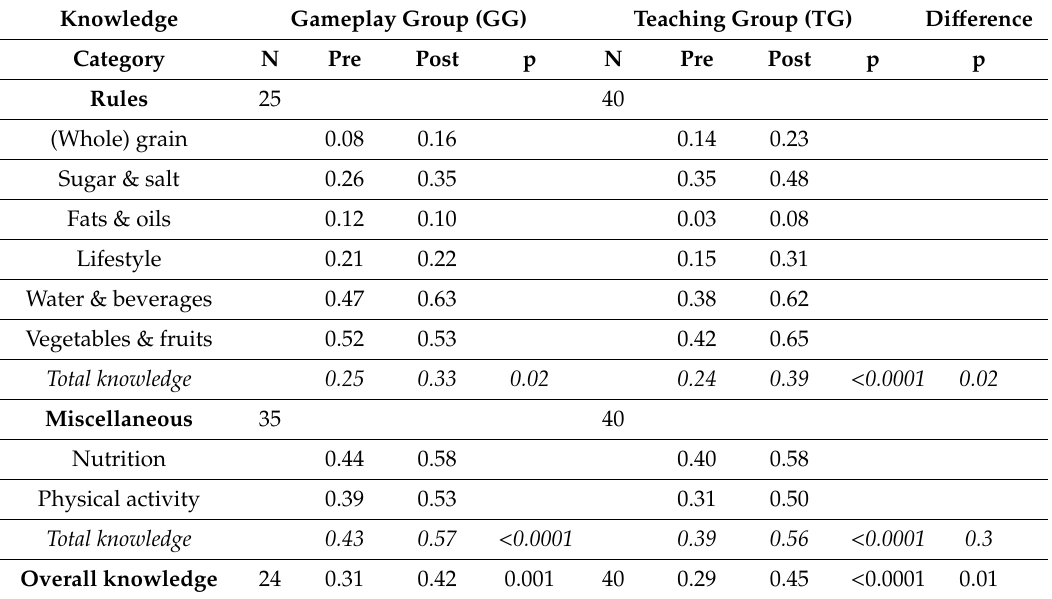
Table 4. Changes in knowledge from pre- (baseline) to post-intervention by and between groups.